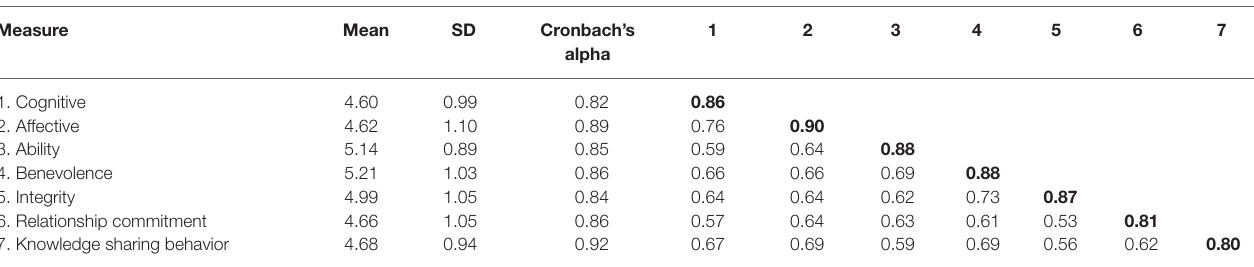
TABLE 2 | Descriptive statistics, correlations, and Cronbach’s alpha.